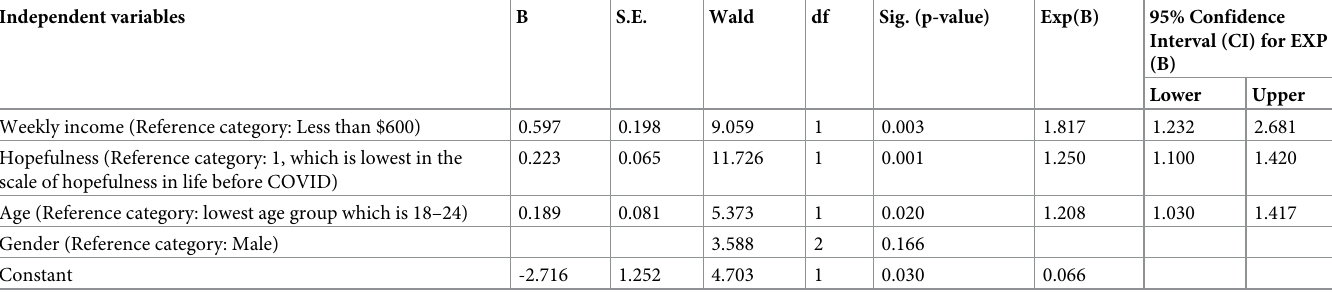
Table 3. Socio-economic determinants of wellbeing–results of binominal logistic regression. South Australia 2020. Independent variables